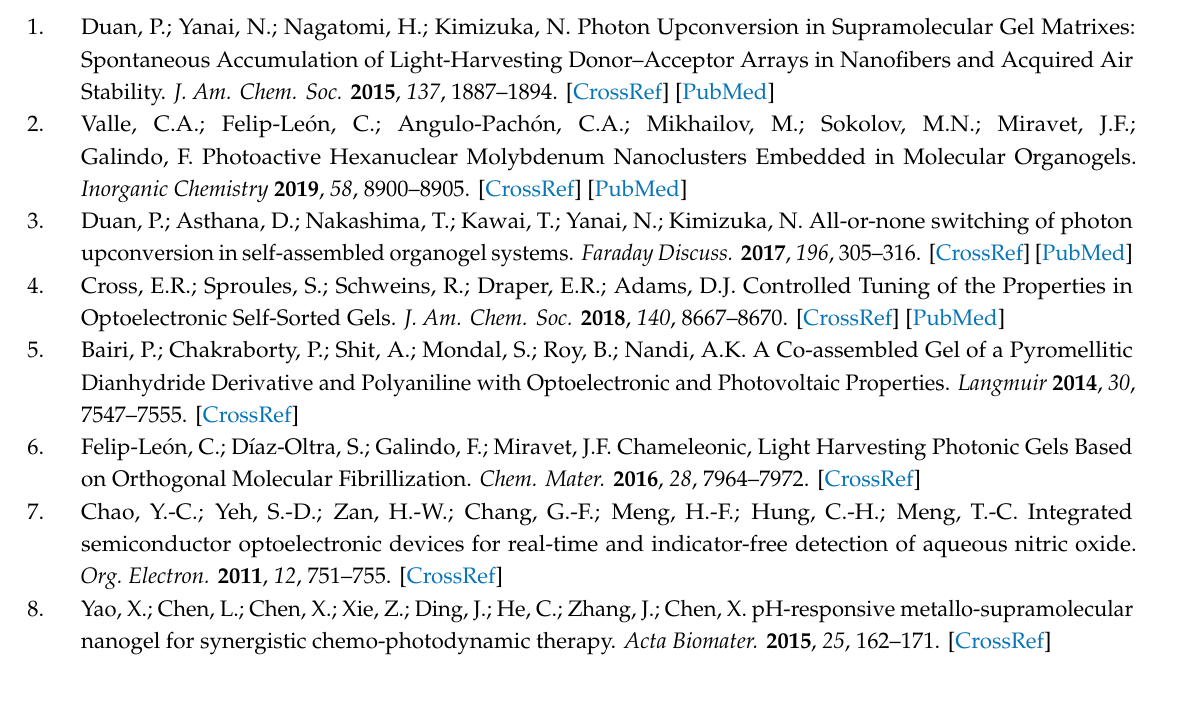
Figure S2: 13C NMR spectrum of compound 1 . Figure S3: IR spectrum of compound 1 . Figure S4: 1H NMR spectrumofcompound 2 . FigureS5: IRspectrumofcompound 2 . FigureS6: Gelationtestresultsofperylenediimide (1) at 0.5 equivalent of 2 (1wt%); (a) Toluene, (b) H2O, (c) Acetonitrile, (d) Methanol, (e) Butanol, (f) Ethanol, in DMSO (33.1 mM). Figure S8: The sol-gel transition temperature of co-assembled gel in the presence of (A) 0.5 and (B) 0.8 equiv. of 2. Figure S9: UV-vis spectra of co-assembled supramolecular gel (1 wt%) dependent on the ratio of compound 2 in DMSO. Figure S10: Luninescnece spectra of sol 1 (blue line) and sol 2 (green line) in DMSO (1 wt%); dash line = co-assembled supramolecular gels, solid line = sols. Figure S11: TEM images of co-assembled supramolecular gel dependent on the ratio of compound 2 ; [2] / [1] = (A) 0.5, and (B) 0.8. Figure S12: SEM image of sol 1 in DMSO (Scale bar = 1 µ m). Figure S13: SEM image of sol 2 in DMSO (Scale bar = 1 µ m). Figure S14: Rheological properties (G’ black dot; G” red dot) of co-assembled supramolecular gel with 0.2 equiv. of 2; frequency sweep tests at 5–1000 Hz and strain 0.1%. Figure S15: Rheological properties (G’ black dot; G” red dot) of co-assembled supramolecular gel with 0.5 equiv. of 2; frequency sweep tests at 5–1000 Hz and strain 0.1%. Figure S16: Rheological properties (G’ black dot; G” red dot) of co-assembled supramolecular gel with 0.8 equiv. of 2; (A) frequency sweep tests at 5–1000 Hz and strain 0.1%, and (B) continuous step strain test at 0.01% and